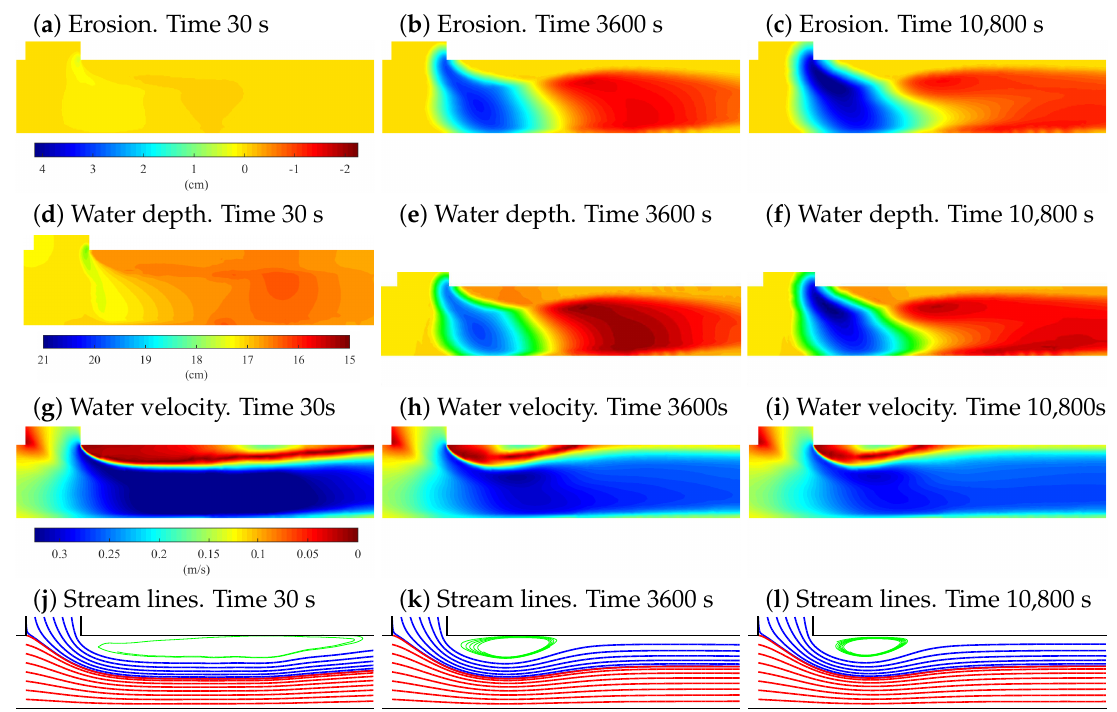
Figure 4. Evolution of bed elevation, water head, water velocity, and stream lines computed with the mathematical model. The first row plots the contour plot of the erosion at time 30 s—panel ( a ), 3600 s—panel ( b ), and 10,800 s—panel ( c ). Erosion is positive and sedimentation negative. The second row shows the water depth at time 30 s—panel ( d ), 3600 s—panel ( e ), and 10,800 s—panel ( f ). The third row includes the water velocity at time 30 s—panel ( g ), 3600 s—panel ( h ), and 10,800 s—panel ( i ). The last row includes the stream lines at time 30 s—panel ( j ), 3600 s—panel ( k ), and 10,800 s—panel ( l